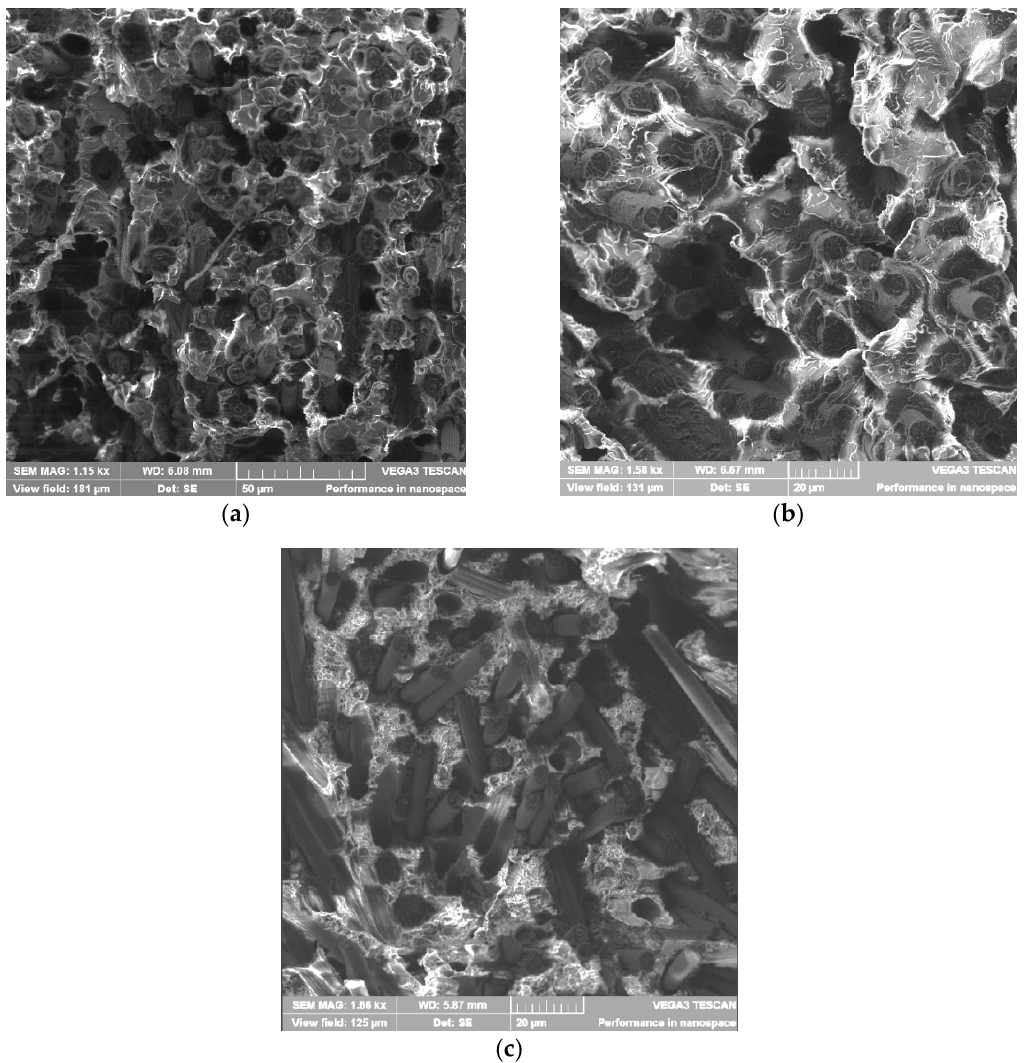
Figure 8. Scanning electron microscope (SEM) images of the broken surface of carbon-filled samples: ( a ) - PEI-CF; ( b ) - PEI-CF + 15% OPSU; ( c ) - PEI-CF + 10% PC.